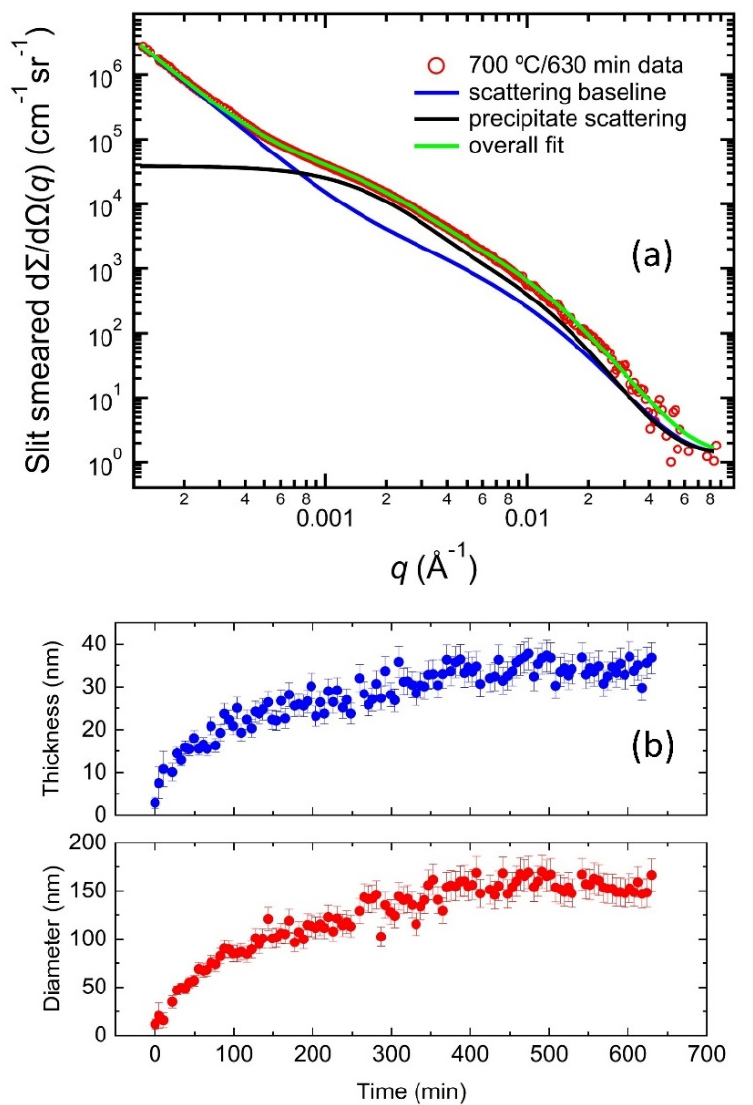
Figure 7. ( a ) An illustration of the SAXS model used in this work. The data were acquired at 630 min during the heat treatment at 700 ◦ C. The overcall scattering comprises two parts: (1) scattering baseline and (2) excess scattering from the δ phase precipitates. ( b ) The time-dependent evolution of the mean diameter (major dimension) and thickness (minor dimension) of the δ phase precipitates. Figure 7b shows the evolution of the mean thickness (minor dimension) and diameter (major dimension) of the δ phase precipitates at 700 ◦ C as a function of time. The thickness and diameter demonstrate a similar trend, with an initial rapid increase followed by a gradual increase. By the end of the heat treatment, the mean thickness and diameter are 34 ± 2 nm and 154 ± 7 nm, respectively. These values are significantly smaller than the values acquired from AM IN625 after 10 h at 870 ◦ C, where the mean thickness and diameter are 52 ± 5 nm and 961 ± 94 nm, respectively [21], again pointing to significantly slower precipitation kinetics at 700 ◦ C. In the context of typical residual stress heat treatment, after a one-hour heat treatment at 870 ◦ C, the mean thickness and diameter are 45 ± 4 nm and 424 ± 40 nm, respectively [21]; after a two-hour heat treatment at 800 ◦ C, the mean thickness and diameter, depending on the build condition, range between 61 nm to 77 nm and 416 nm to 634 nm, respectively [24]. In other words, a stress relief heat treatment at 700 ◦ C for as long as 10 h results in δ phase precipitates significantly smaller than those developed during typical residual stress heat treatment of AM